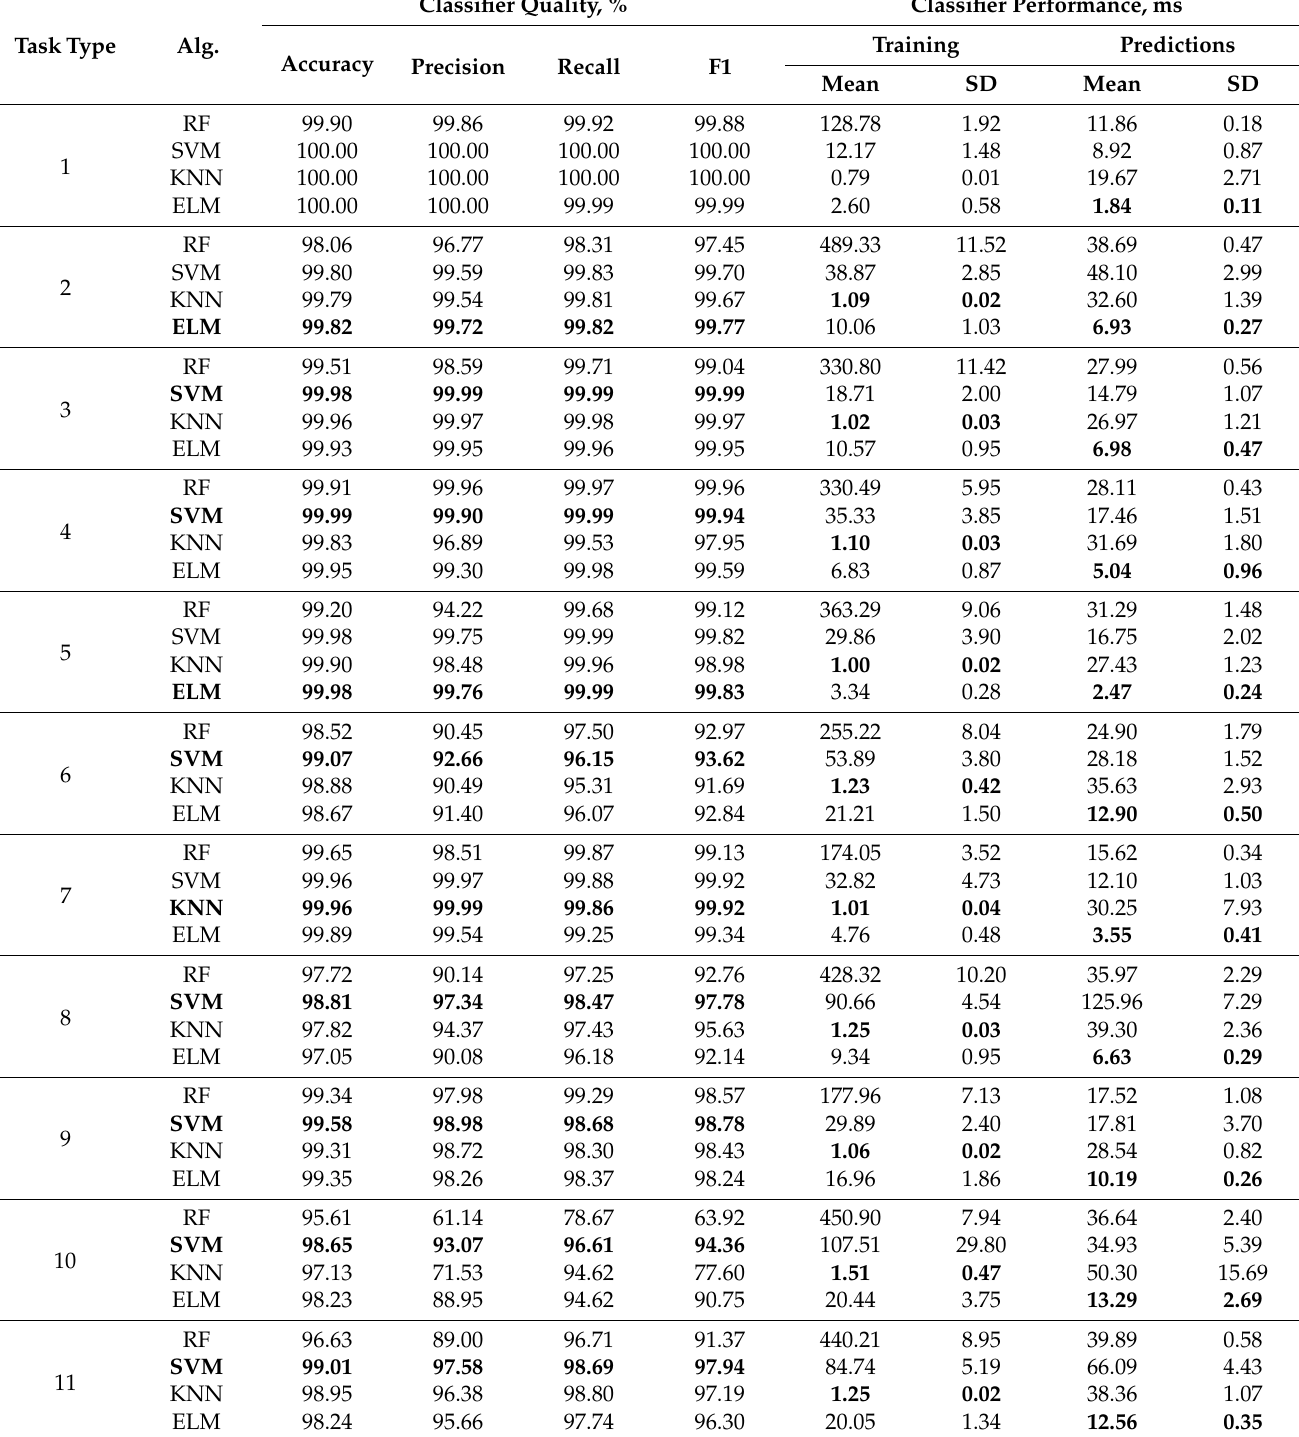
Table 5. Accuracy and performance comparison of the considered